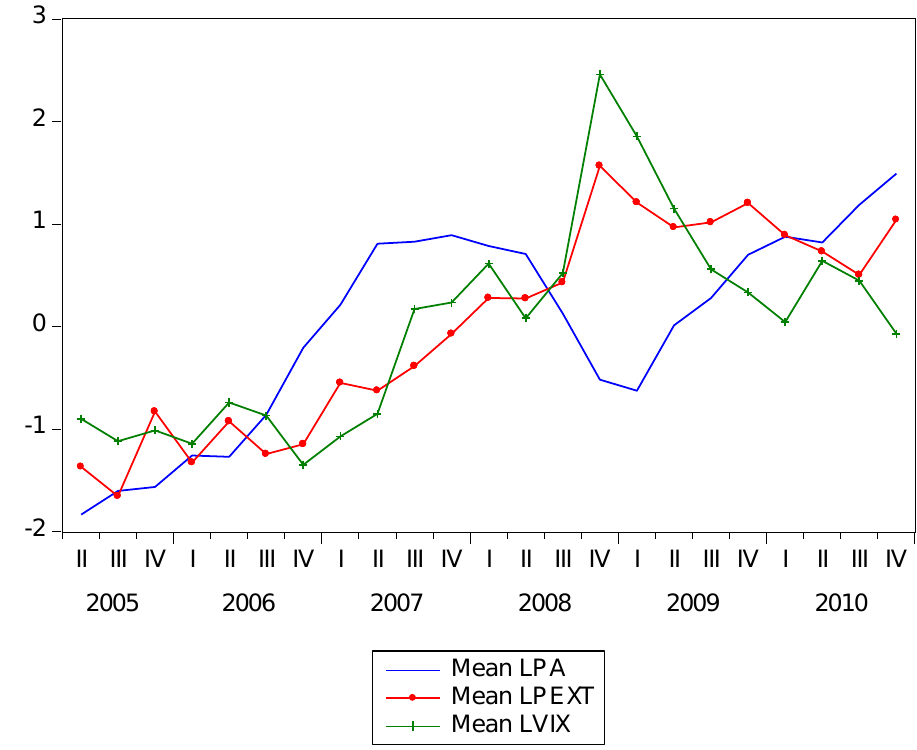
Figure 2. Average behavior of the 29 companies during the period.